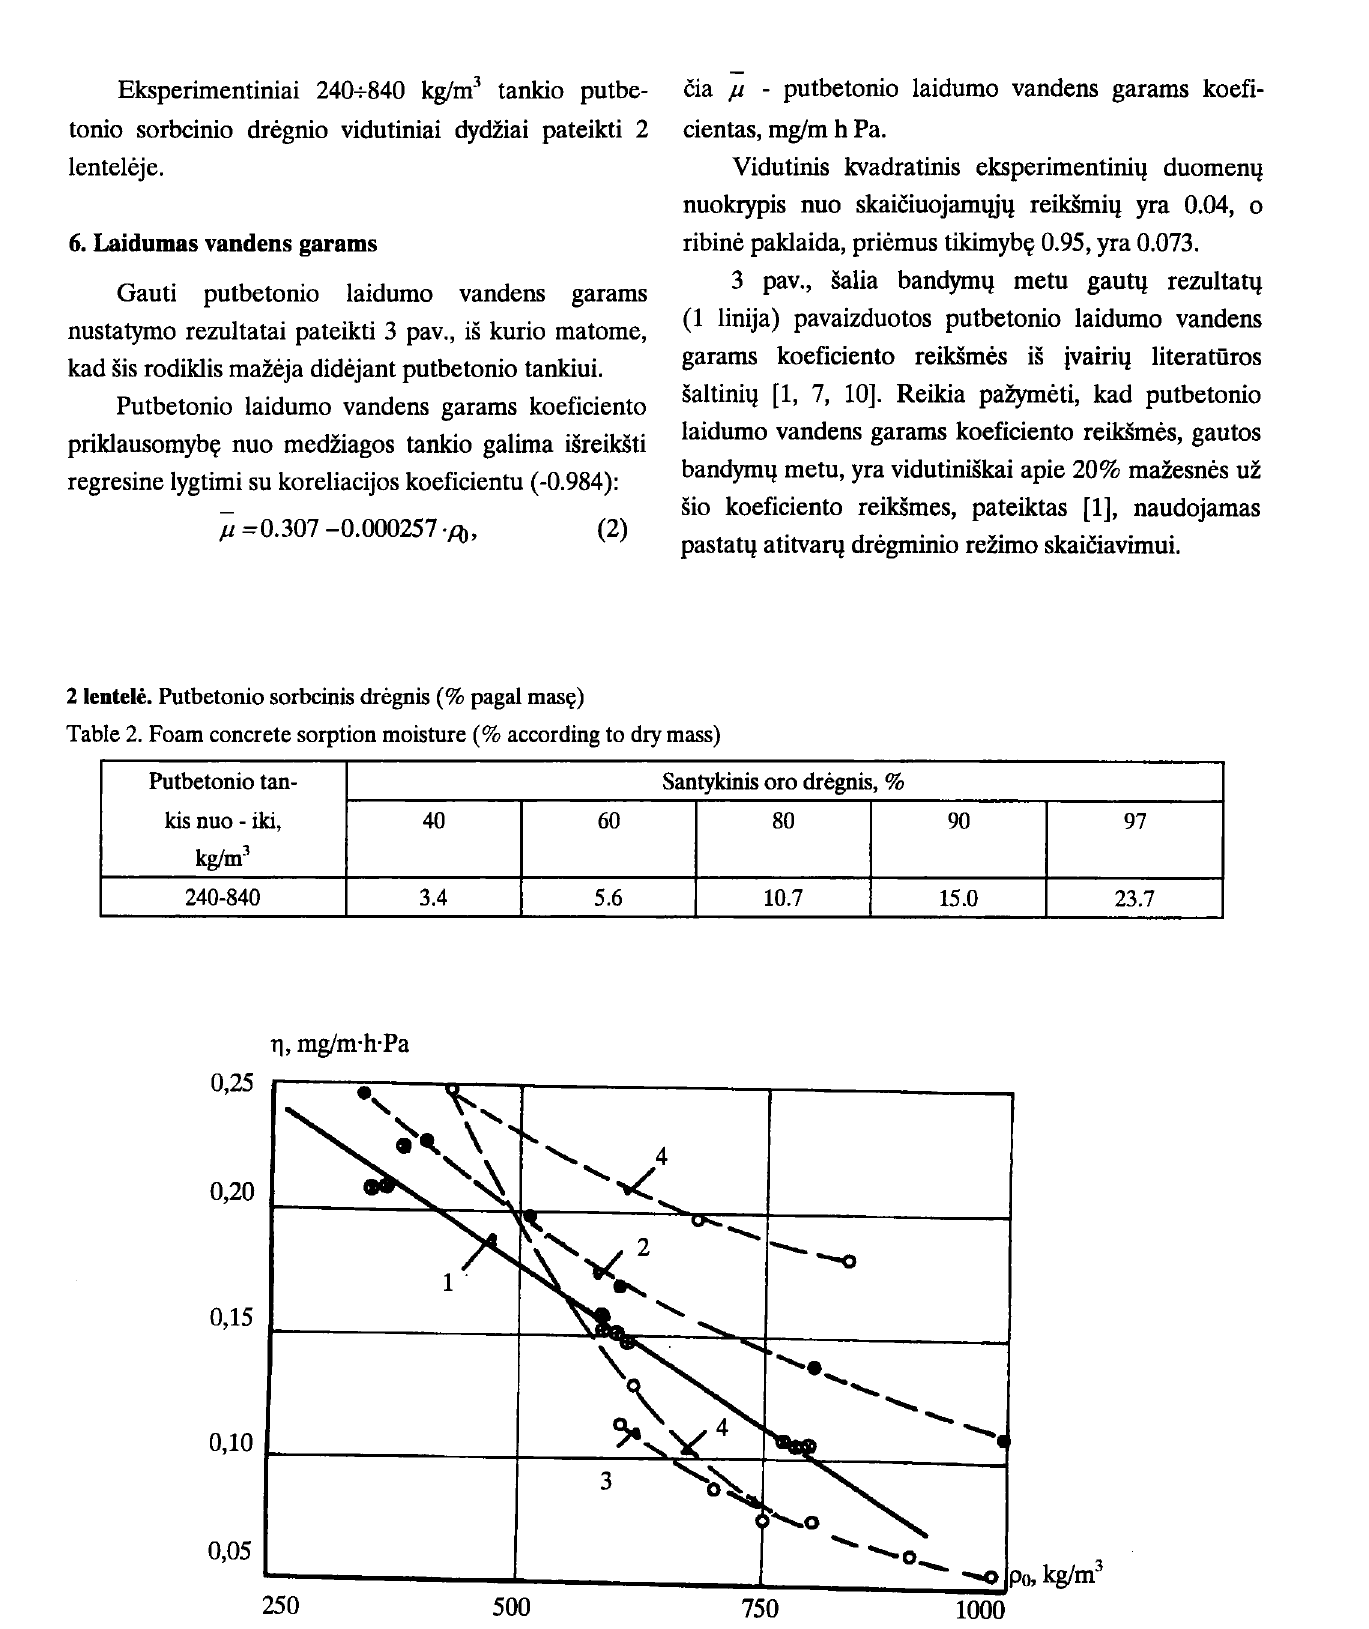
Table 2. Foam concrete sorption moisture(% according to dry mass) Putbetonio tan- Santykinis oro dregnis, % kis DUO - iki,